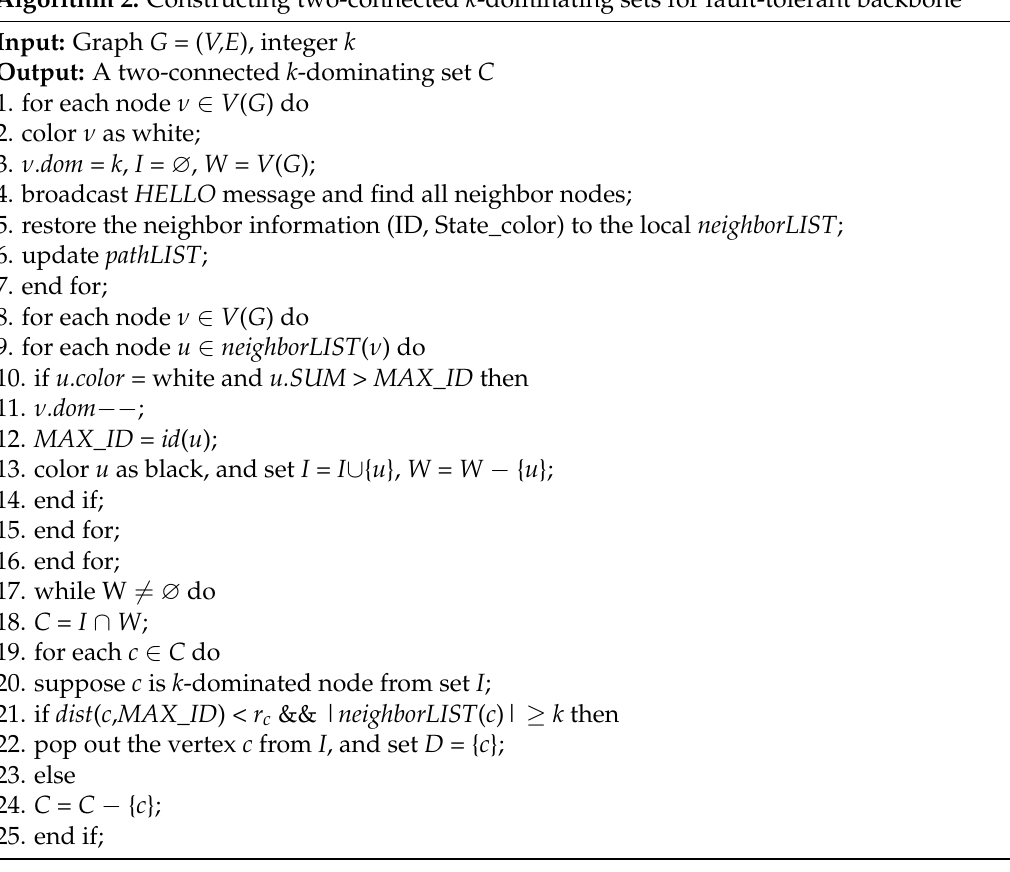
Algorithm 2: Constructing two-connected k -dominating sets for fault-tolerant